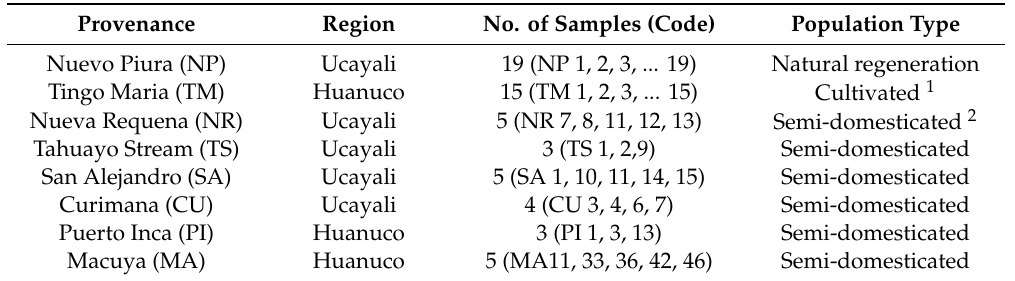
Table 1. Origin of the 58 G. crinita individuals analysed by amplified fragment length polymorphic (AFLP)